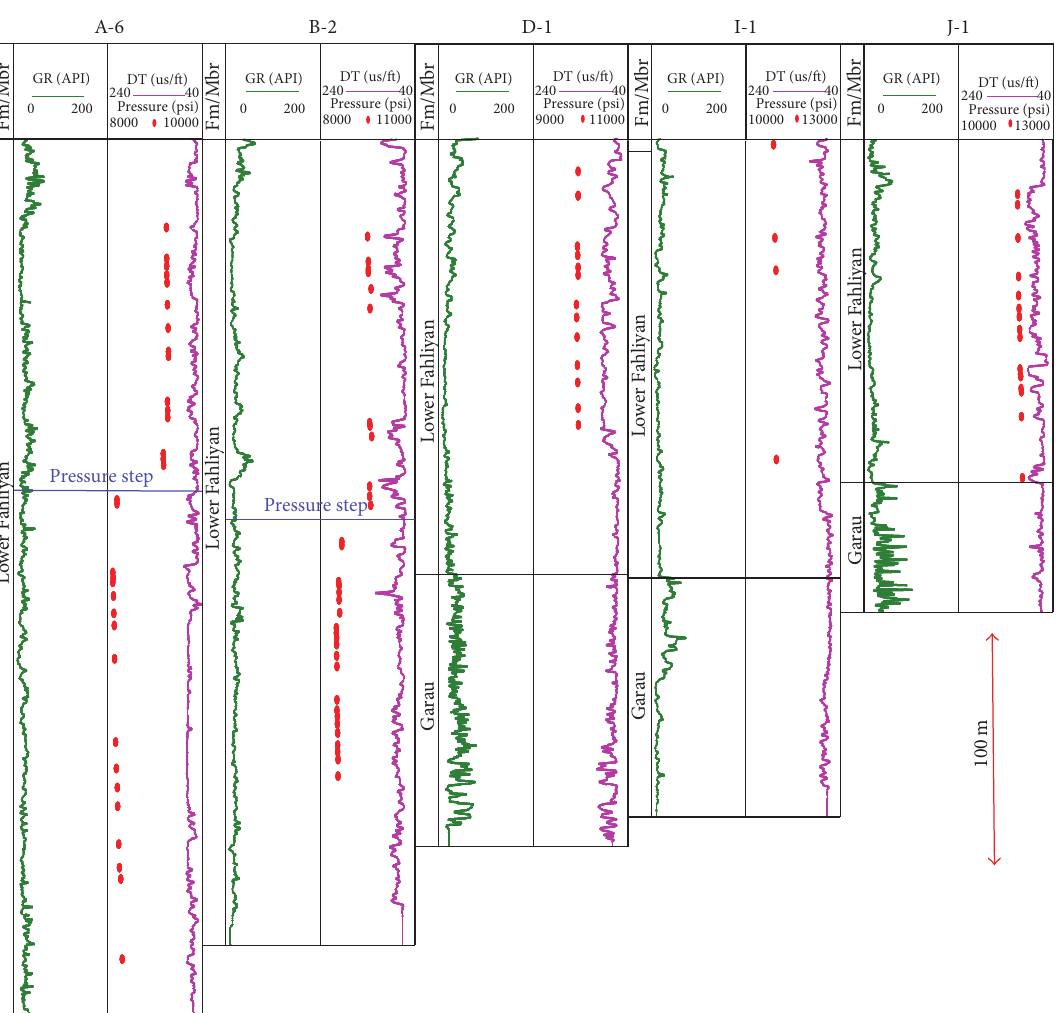
Figure 6: Shown is the stratigraphic correlation chart of the Lower Fahliyan Formation in an overall west–east direction (left to right) through wells A-6, B-2, D-1, I-1, and J-1. The green curve is gamma ray, the pink is sonic travel time, and the red points are the pressure data plotted againstthewirelinelogs.Thebluelineshowsthestratigraphicpositionoftheregionalseal(mainpressurestep)inA-6andB-2wells,separating the upper and lower compartments. Also, the step-wise pressure pattern can be seen in each compartment. The stratigraphic position of the regional seal is correlatable through fields A and B. The equivalent strata of lower compartment (below the main pressure step) change facies to nonreservoir Garau Formation in wells D-1, I-1, and